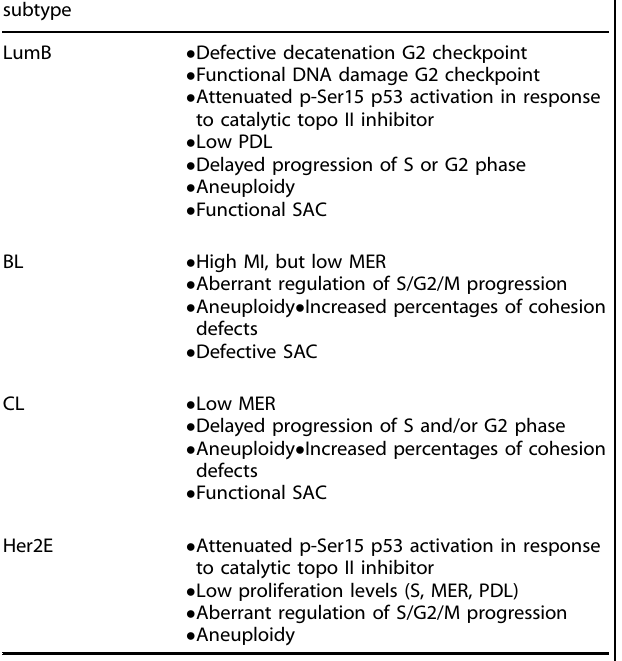
breast cancer cell